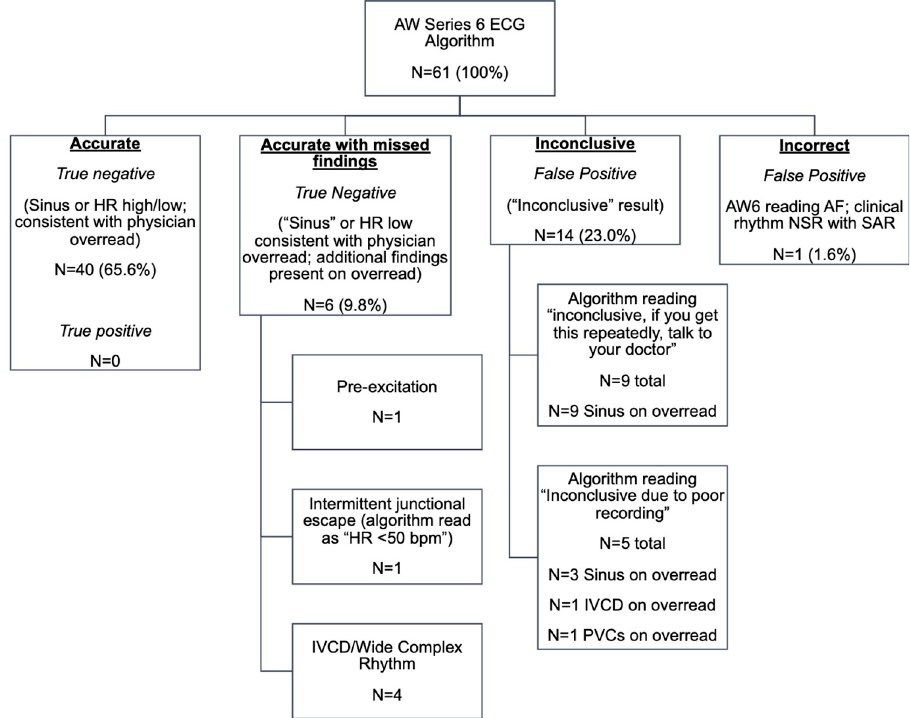
Fig 5. Analysis of AW6 automated Interpretation algorithm. Of note, no patients were in an acute arrhythmia at the time of ECG collection. Abbreviations: AF = atrial fibrillation, HR = heart rate, IVCD = intraventricular conduction delay, NSR = normal sinus rhythm, PVCs = premature ventricular conductions, SAR = sinus arrhythmia.